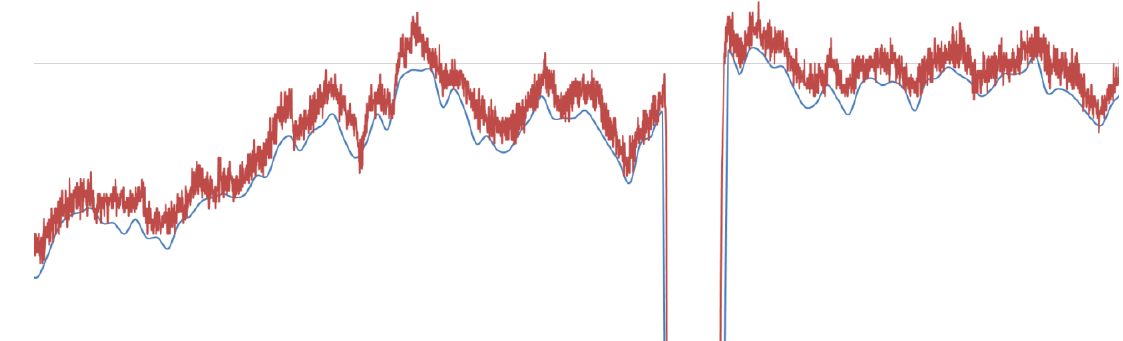
Figure 7: Zooming around the dip of Figure 5, for sampling times